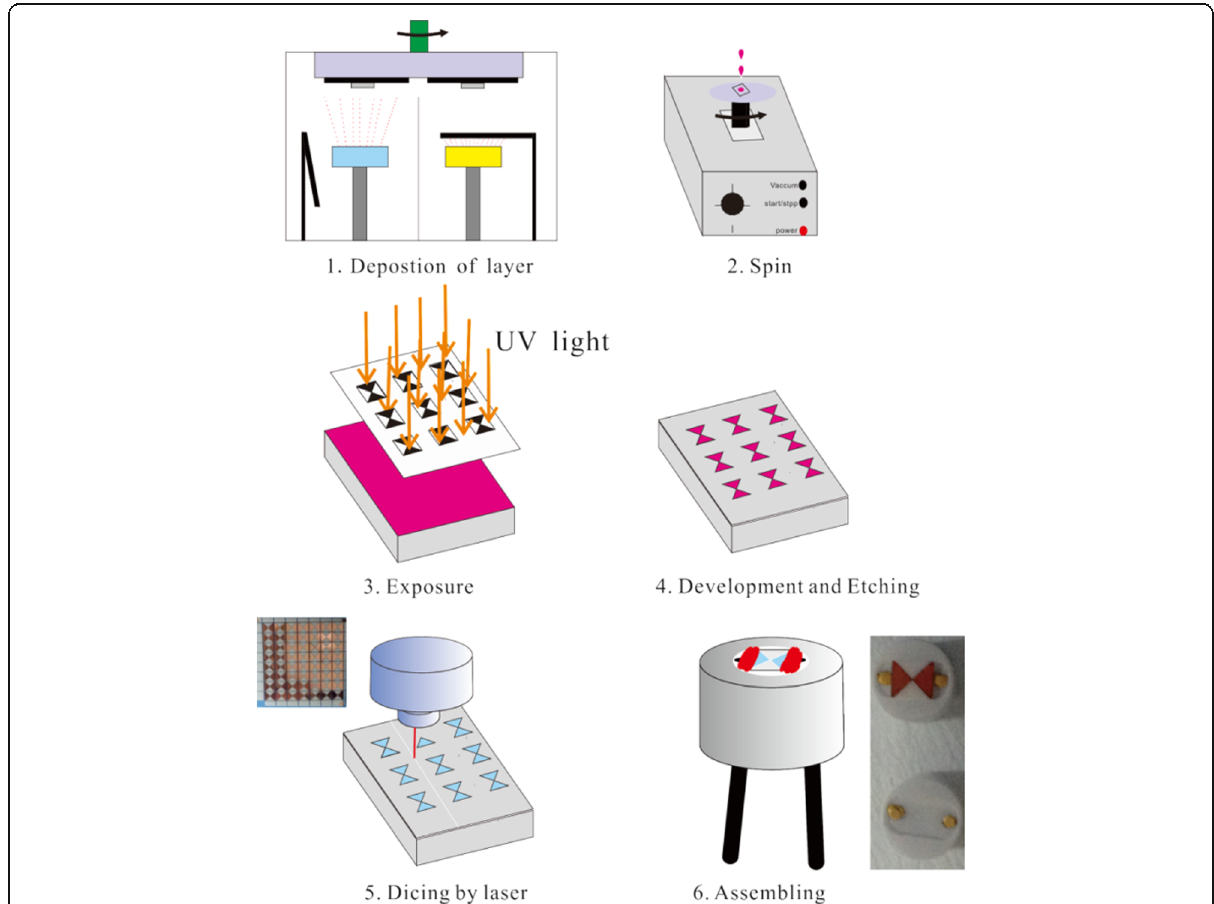
Fig. 1 Fabrication process of micro plasma